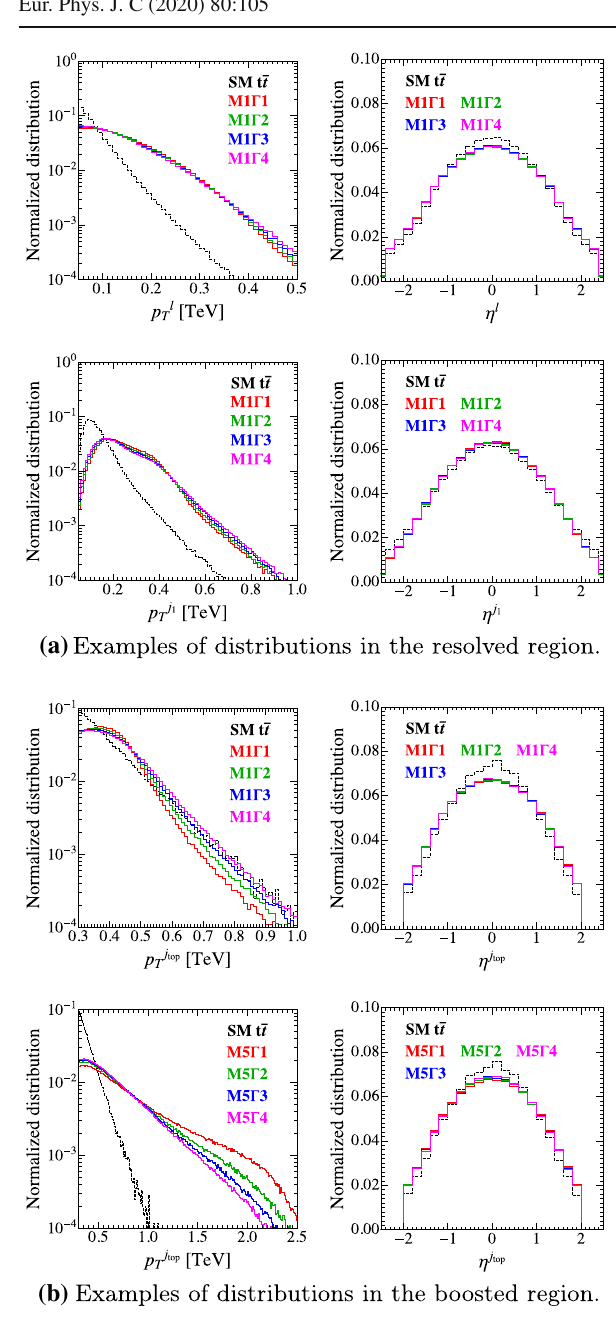
Fig. 1 Distributions of some low-level observables used to train a DNN. Selection cuts in Tables 1 and 2 are applied